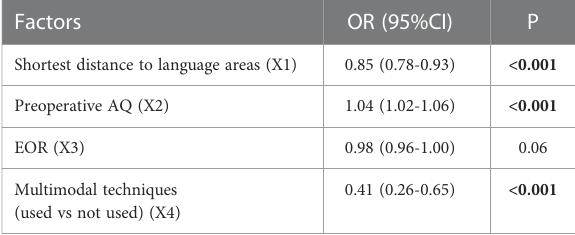
TABLE 5 Factors for temporary language de fi cit by multivariate analysis.